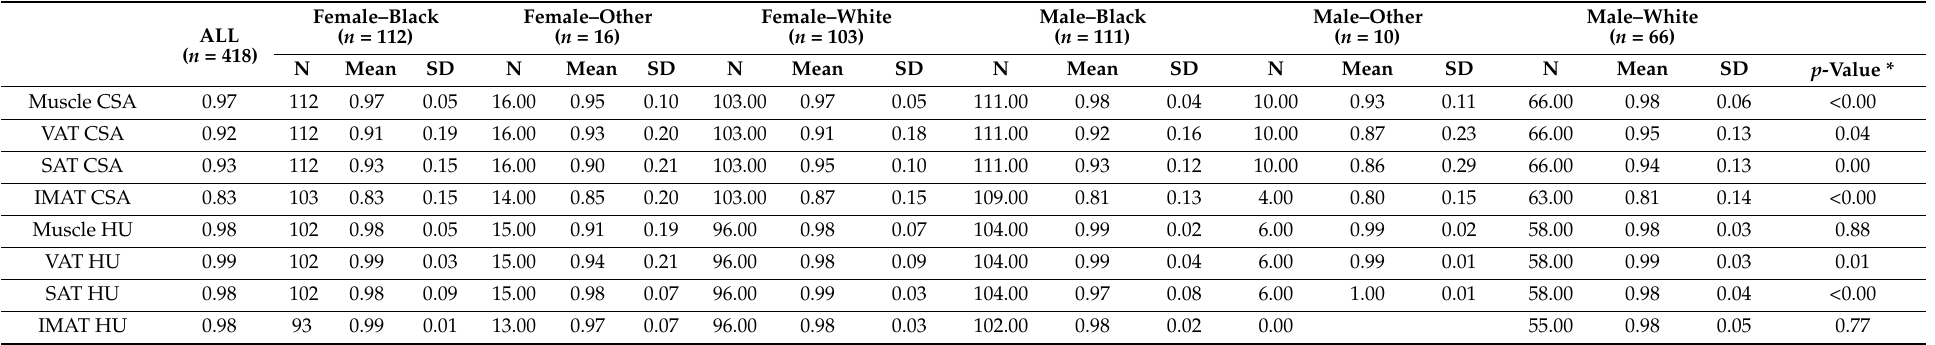
Table 5. DSC by Sex and Race/ethnic